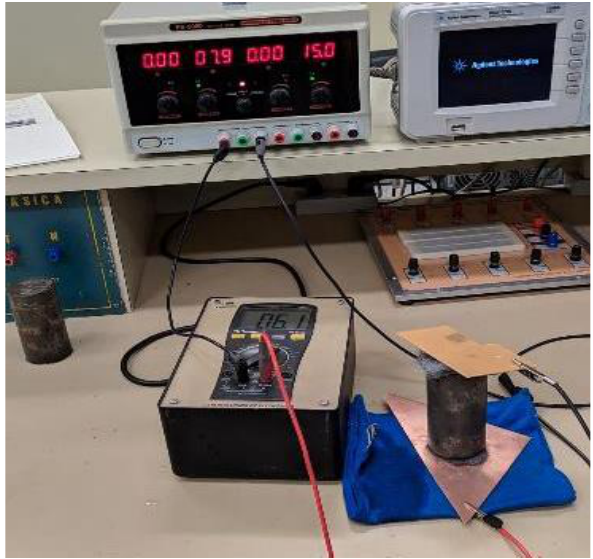
Figure 4. Experimental setup of the electric-volumetric resistivity test.